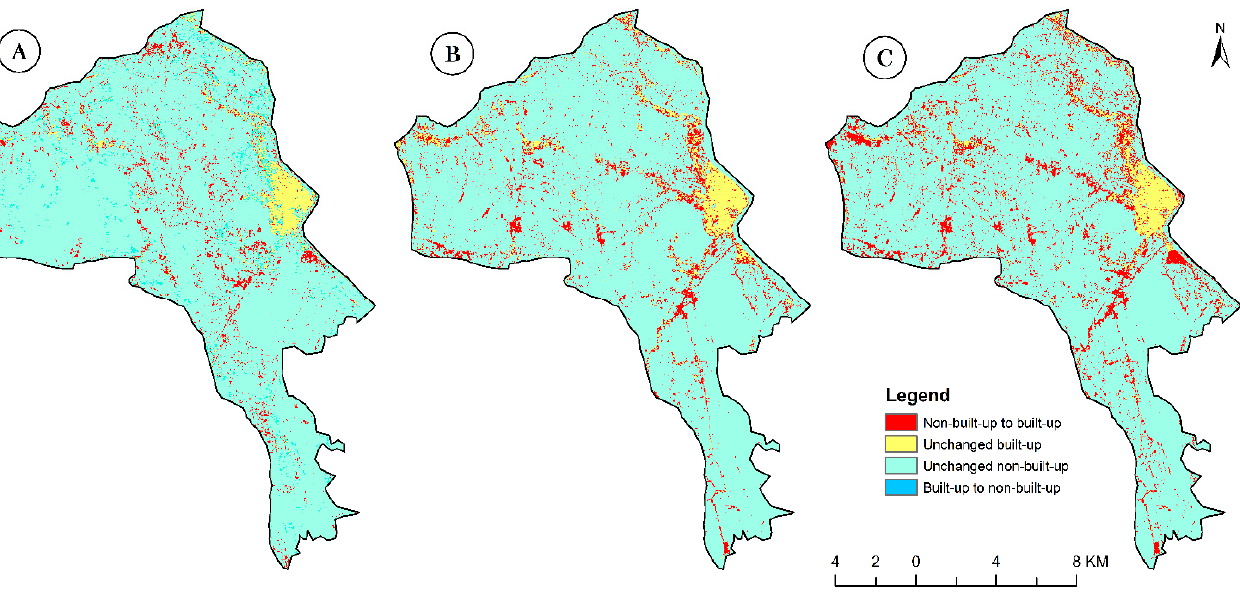
Figure 5. Built-up change maps between the years of ( A ) 2001 and 2011, ( B ) 2011 and 2021, and ( C ) 2001 and 2021 of English Bazar.